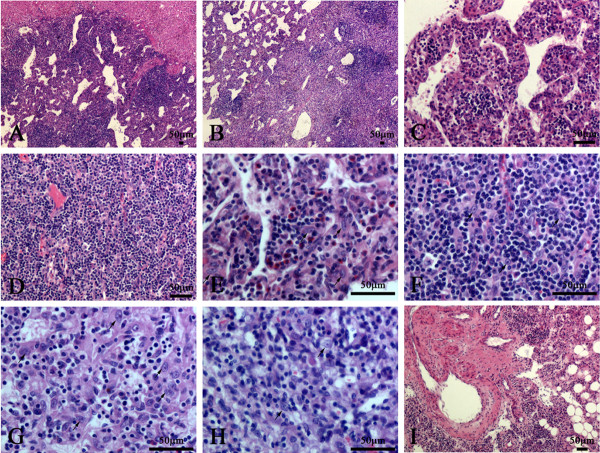
Histological features of this case.A: The neoplasm was demarcated from the surrounding liver tissues with relative clear boundary. B: The neoplasm showed a solid cellular growth pattern and dilated vascular channels. C: The cavernous-like vascular areas were composed of dilated vascular channels lined by monolayer flat endothelial cells, and separated by cellular septa. D: The solid cellular areas contained many capillaries with the narrow or collapsed lumen. E and F: The tumor was characterized by the infiltration of numerous inflammatory cells in the background, including small lymphocytes, plasma cells, and eosnophils. G and H: The cellular areas and the septa of cavernous-like vascular areas were composed of spindled and histiocytoid cells (arrow) with slightly eosinophilic cytoplasm and small central nucleoli. I: Mature adipocytes and thick-walled blood vessels were focally observed at the boundaries between the tumor and surrounding liver tissues.